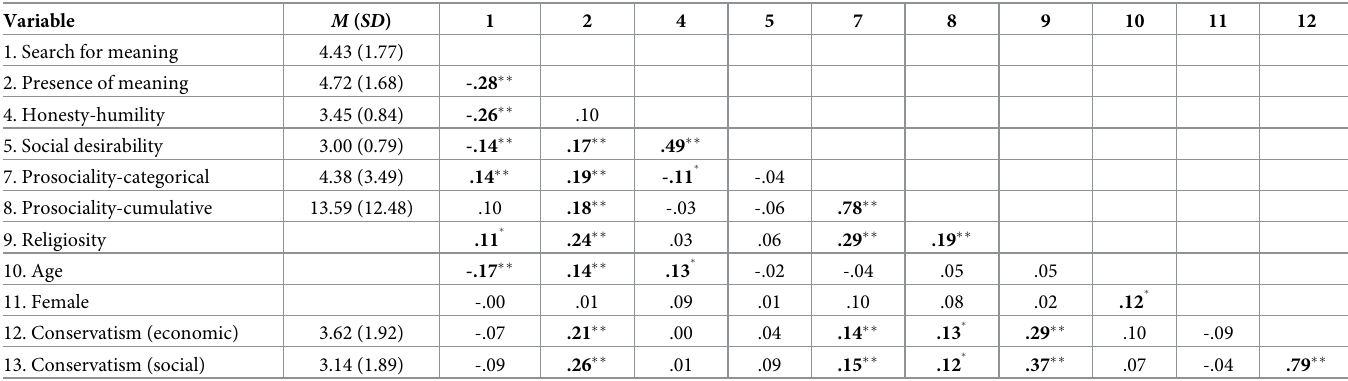
Table 10. Correlations matrix and descriptives in Study 5.